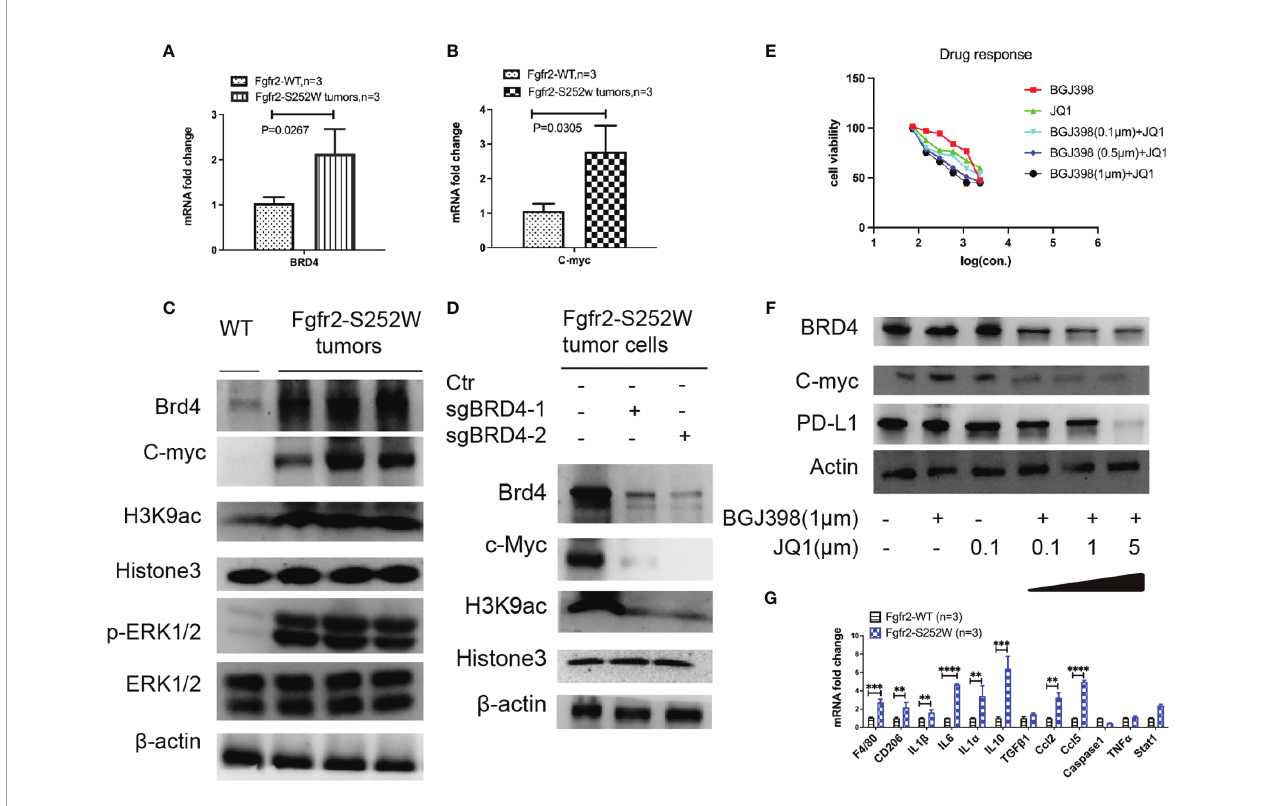
FIGURE 5 | (A, B) RT-PCR analysis of the mRNA levels of Brd4 (A) and c-Myc (B) in tumors from the activation of Fgfr2-S252W transgenic mice. (C) Immunoblots with antibodies speci fi c for the H3K9 acetylated lysine residues of histone H3 and pathway analysis of the activation of FGFR2 tumors or wild type (WT). (D) Immunoblots with antibodies speci fi c for the H3K9 acetylated lysine residues of histone H3 and pathway analysis after knockout of BRD4 by the CRISPR-Cas9 system and non-target as the control. (E) Assessment of the drug response of BGJ398, JQ1, or the combined treatment of Fgfr2-S252W tumor cells with the Alamar blue assay. (F) Western blot analysis revealing that BGJ398 and JQ1 inhibit BRD4, c-Myc, and PD-L1. (G) In fl ammation analysis using real- time RT-PCR from Fgfr2-S252W or WT mouse. P-values by using GraphPad Prism 7 Software. **p < 0.01, ***p < 0.001, ****p <